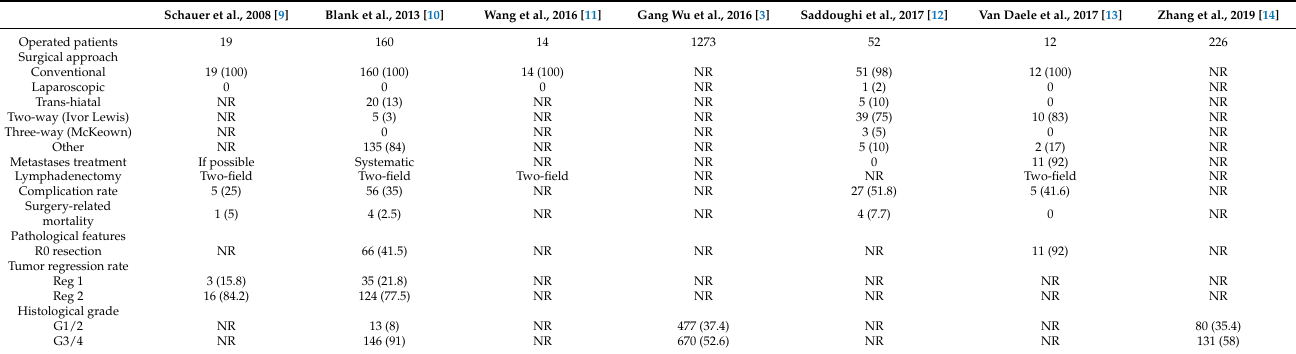
Table 4. Surgical features, postoperative outcomes, and pathological analyses.